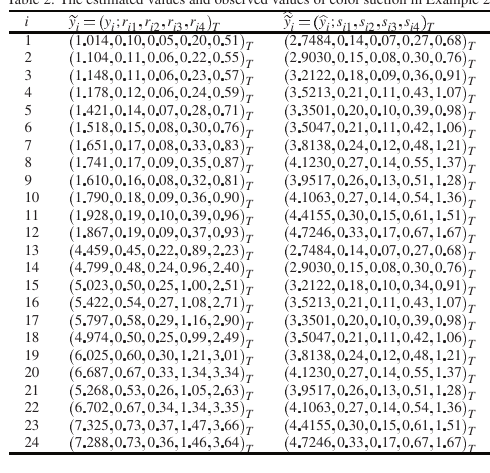
Table 2. Theestimated valuesand observedvalues ofcolorsuction inExample 2. i